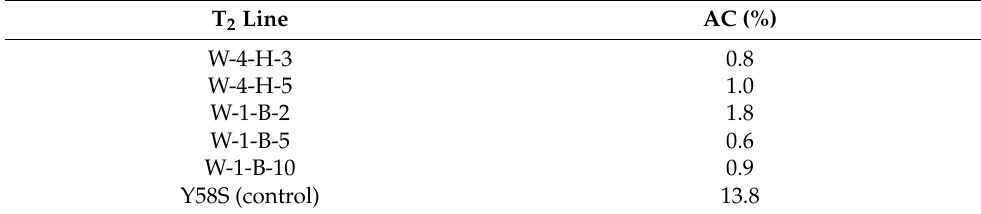
Table 4. AC contents of polished rice of T 2 homozygous mutant lines.